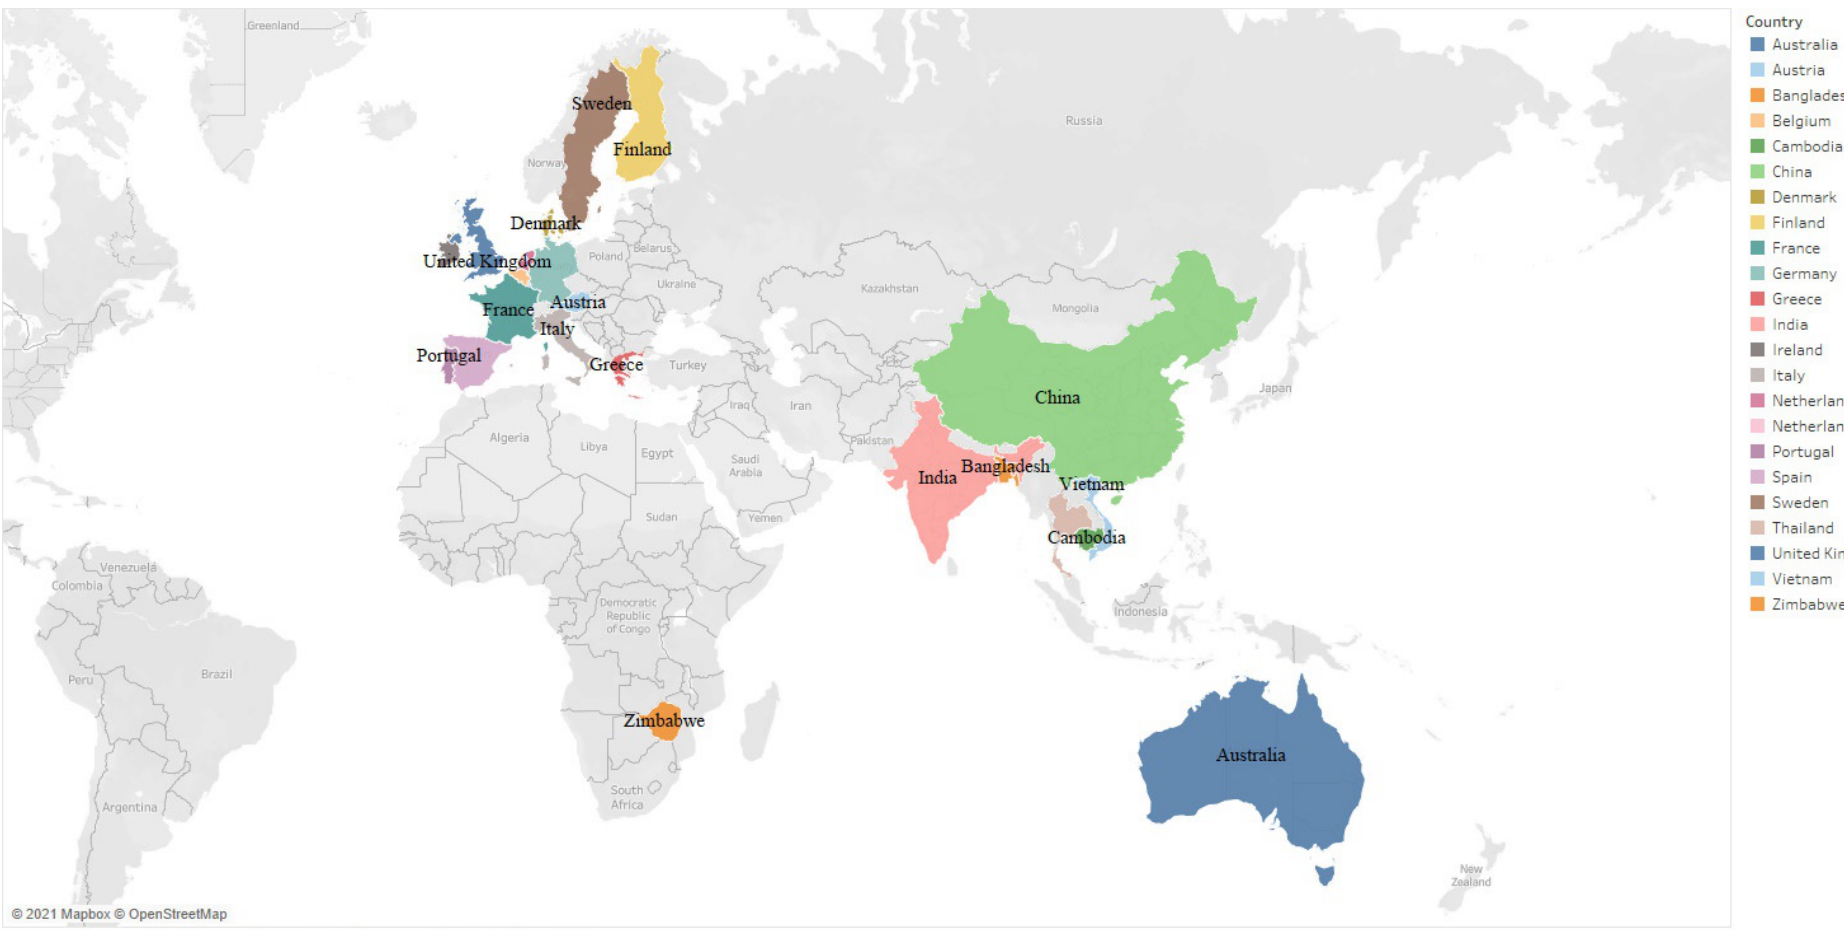
Figure 2. Global distribution of countries—22 countries across 11 studies.